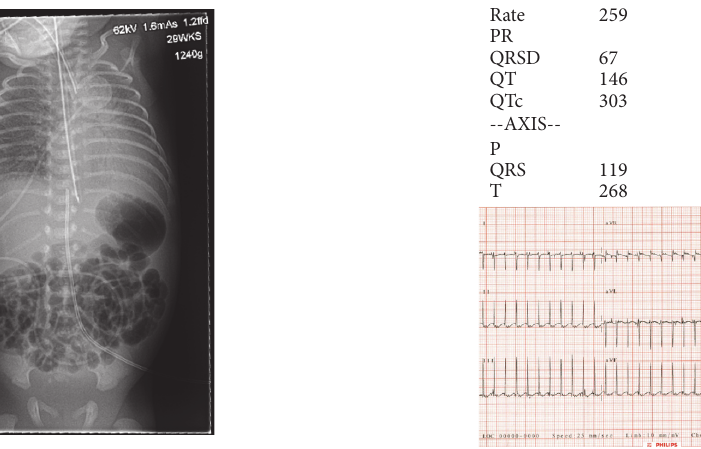
Figure 2: ECG demonstrating narrow complex tachycardia; rate: 260